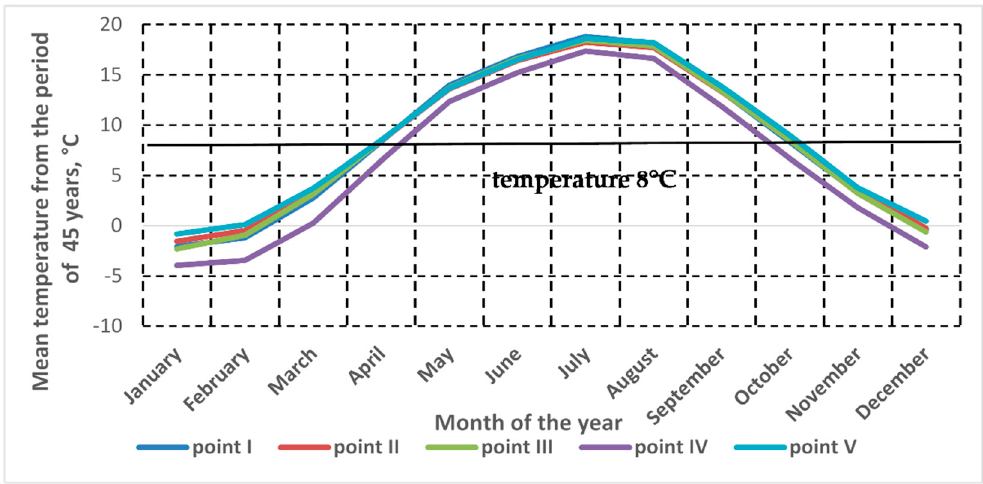
Figure 2. Annual distribution of average temperatures for 5 measurement points (every point from different geographic regions of Poland, i.e., one from: central, west, east, north, and south) during a period of 45-years.